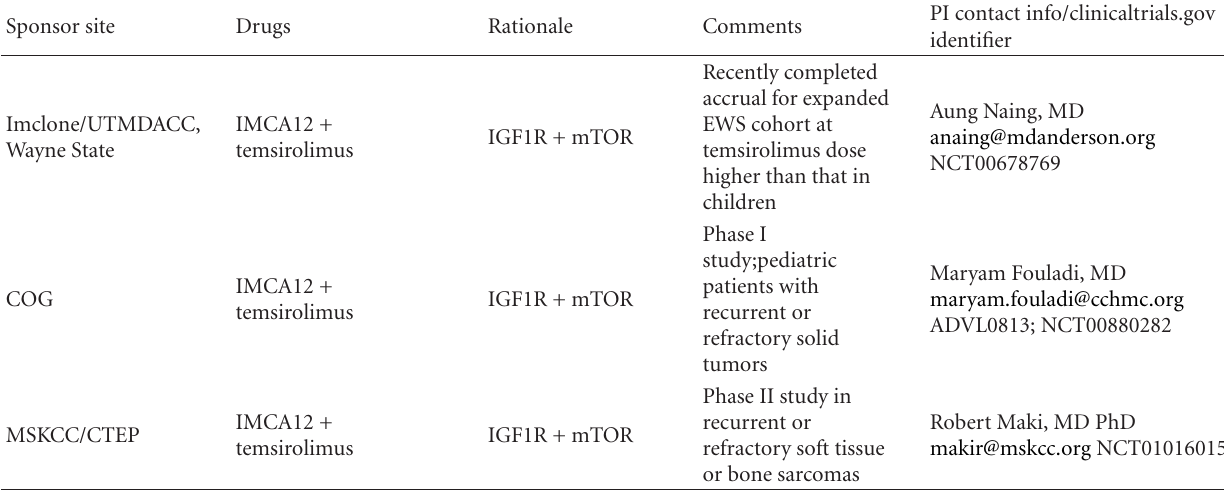
Table 6: Current and future trials of targeted therapy for refractory and/or recurrent Ewing’s sarcoma